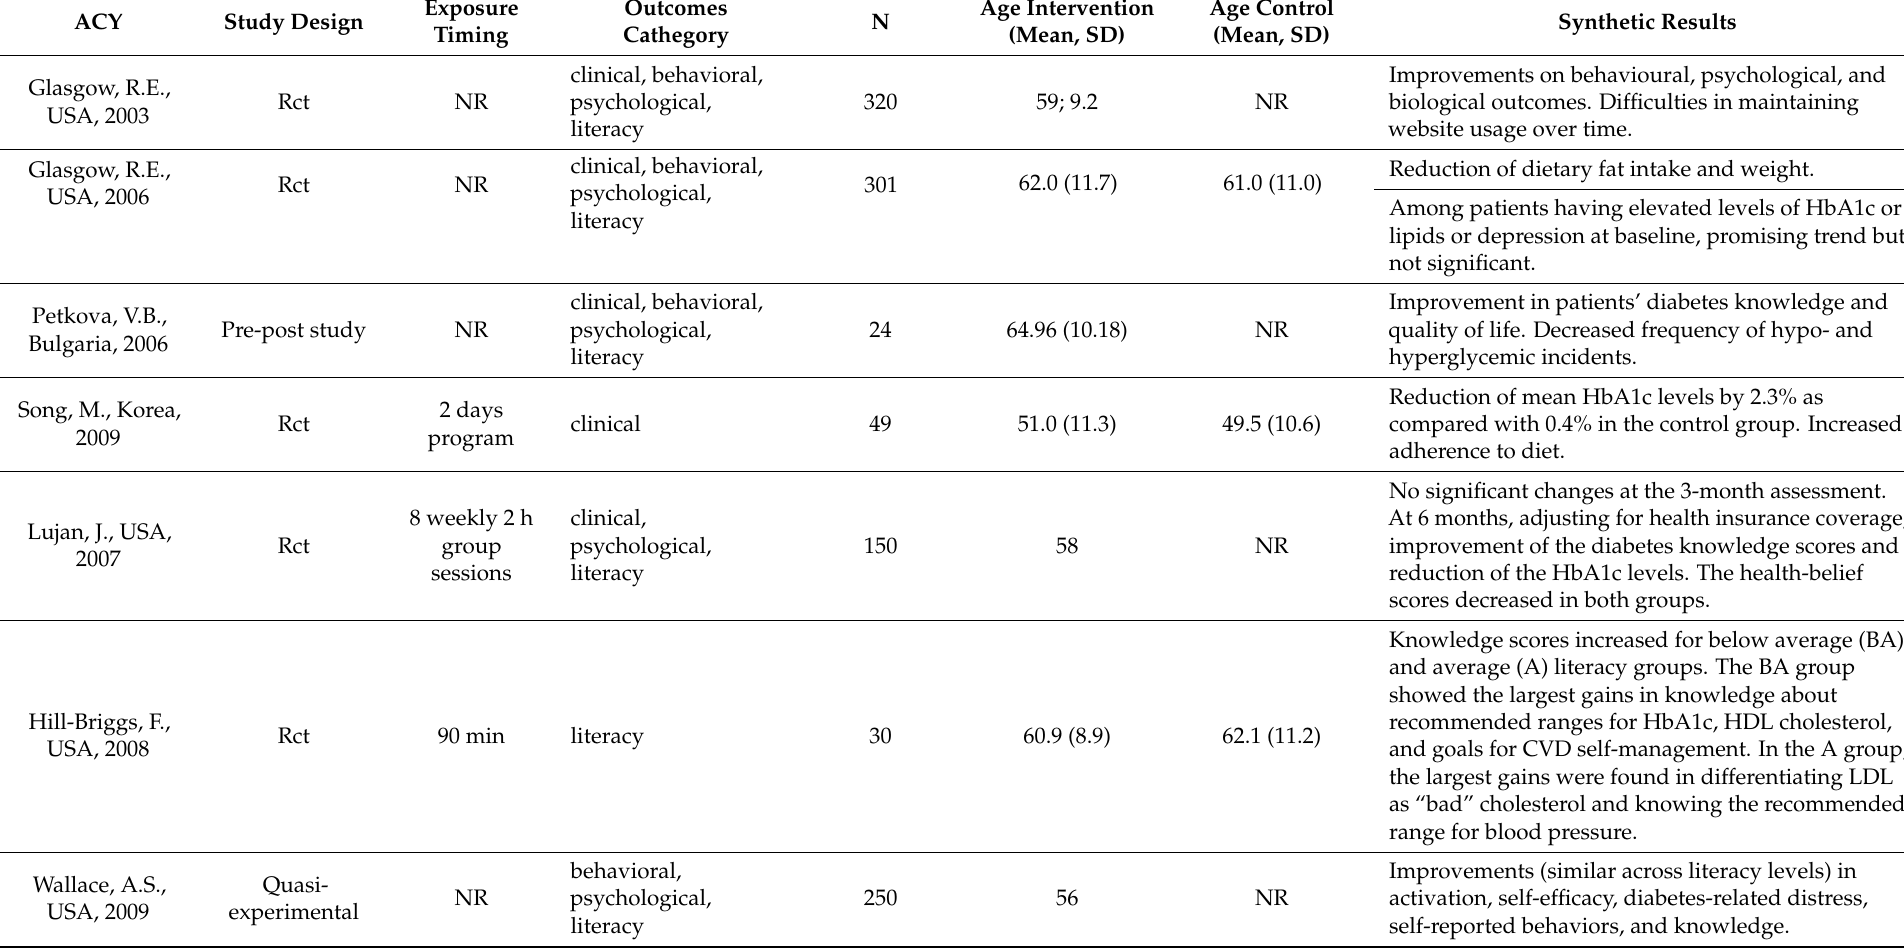
Table 1. Summary of the selected studies in the current systematic